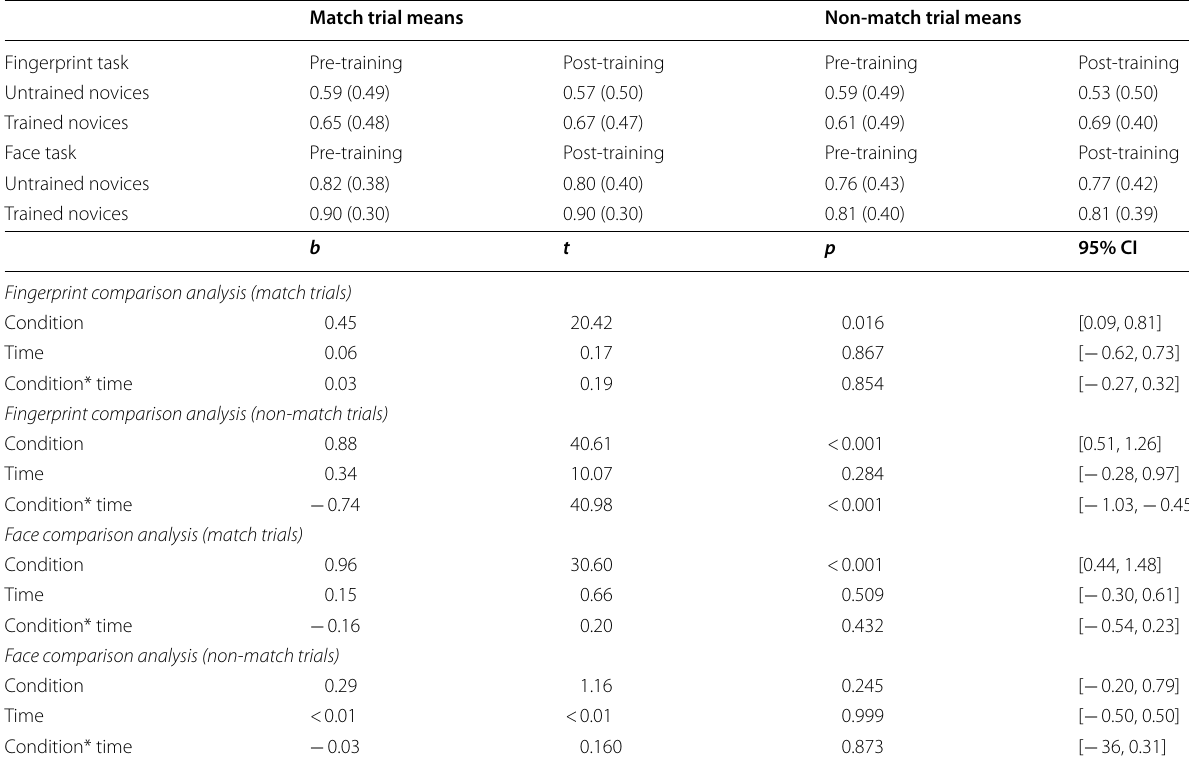
See Table 1 Table 1 Means, standard deviations (in brackets), and analyses on match and non-match trials pre-training and post-training between conditions in Experiment